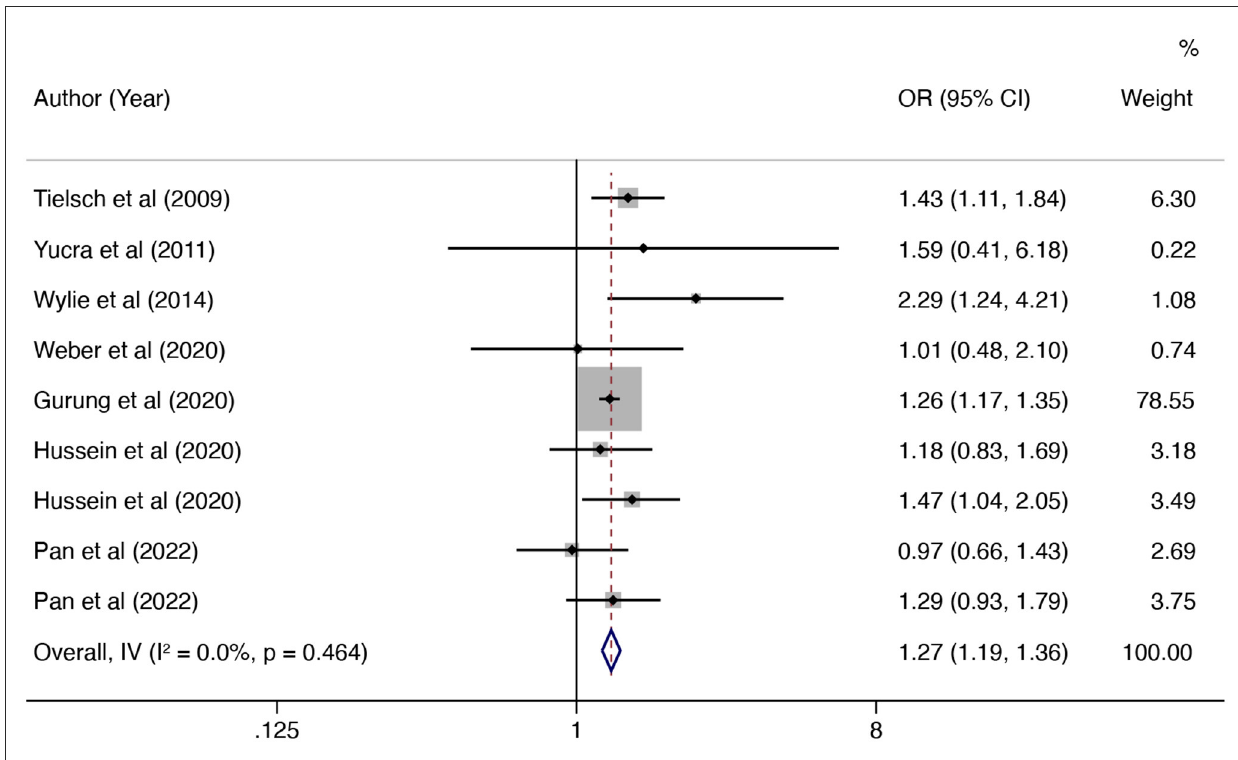
FIGURE5 Forest plot showing the effect of polluting cooking fuels on preterm birth